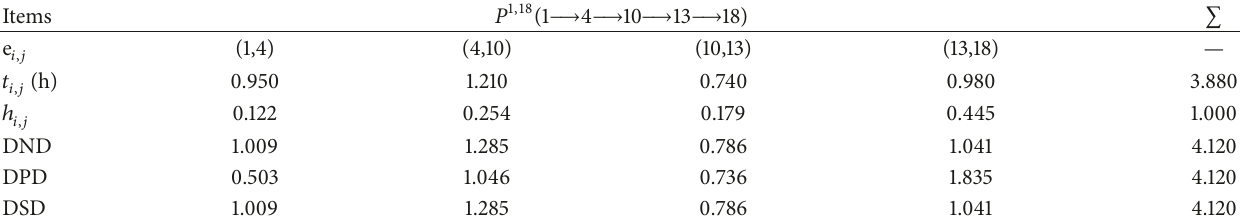
Table 5: The time delay of P 1,18 with the better timeliness and the poorer robustness.